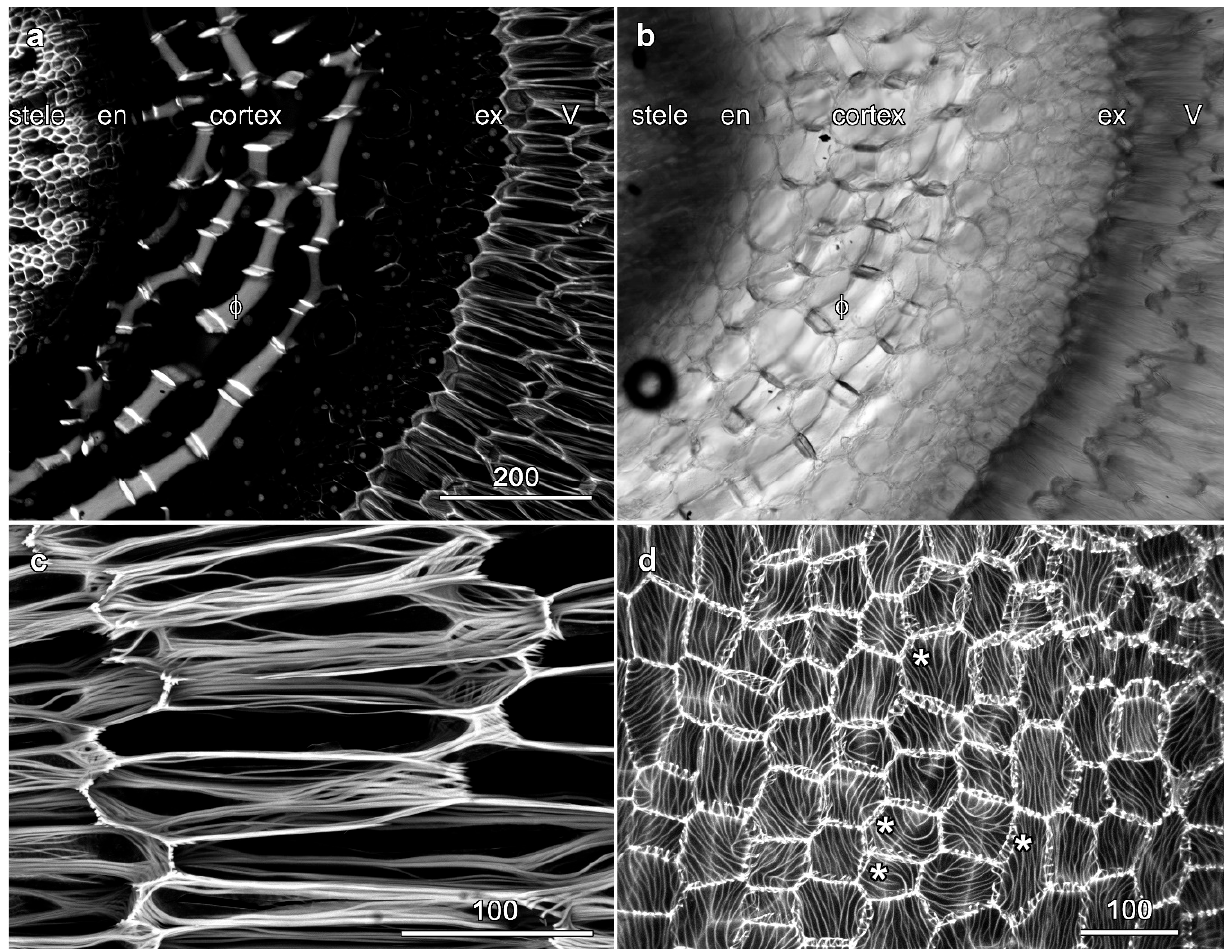
Figure 3. Velamen organization in Laelia anceps roots. Images ( a , c , d ) are maximum projections of confocal optical series of berberine hemisulfate ( a ) and basic fuchsin staining ( c , d ). ( a , b ) Cross section showing lignified cell walls, along with a concurrent transmitted light image. The velamen (V) surrounds the lignified exodermis (ex) and the cortex. Extensive phi thickenings ( ϕ ) are present within the cortex. ( c ) Higher resolution image of cell wall thickenings in the highly elongated inner velamen cells. ( d ) Longitudinal section showing wave-like wall thickenings in the outer surface of the velamen. See also Supplementary Movies S3 and S4. Bar in ( a ) = 200 µm for ( a , b ); bars in ( c , d ) = 100 µm.